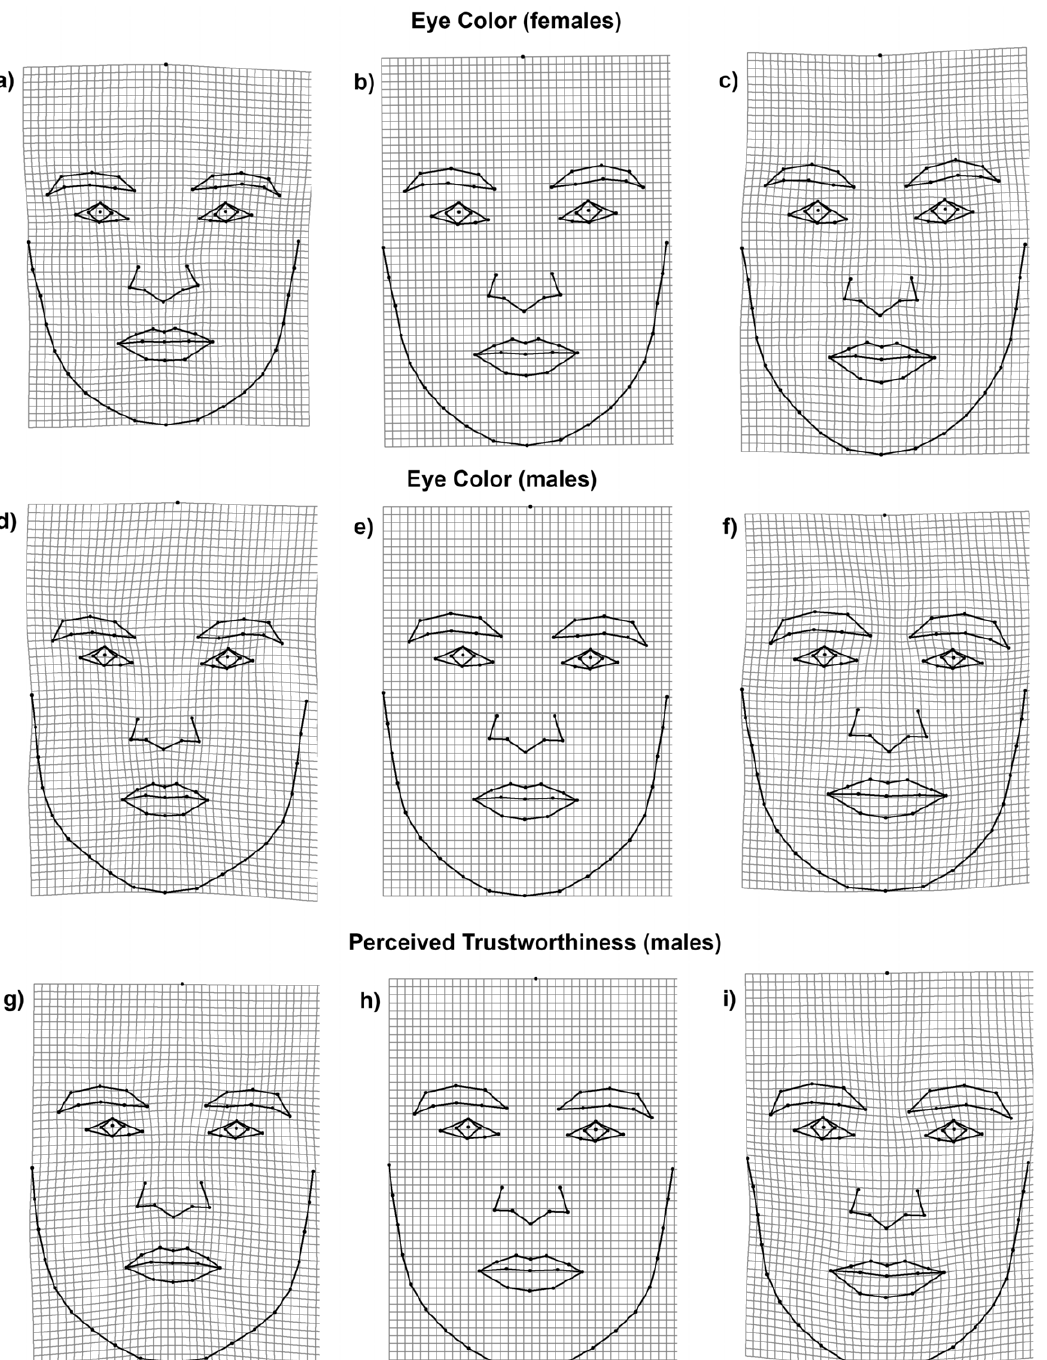
Figure 2. Shape changes associated with eye color and perceived trustworthiness. Thin-plate spline visualizations of the way face shape correlates with eye color (a–f) and trustworthiness (g–i). Generated face shapes of blue-eyed woman (a) and brown-eyed woman (c) compared to average female face (b). Generated face shapes of blue-eyed man (d) and brown-eyed man (f) compared to average male face (e). Generated face shapes of untrustworthy-looking man (g) and trustworthy-looking (i) man compared to average male face (h). The TPS grids of perceived trustworthiness for women are not shown because shape analysis did not meet statistical significance. The generated facial images (a–f) were magnified 3x for better readability. doi:10.1371/journal.pone.0053285.g002 or more genes with large effect, and further modified by dozens of other genes [39–42]. Due to recombination, there can be no stable The first explanation is non-random association between alleles association between a particular eye color and a particular face due to gene linkage disequilibrium . Eye color is mainly affected by one